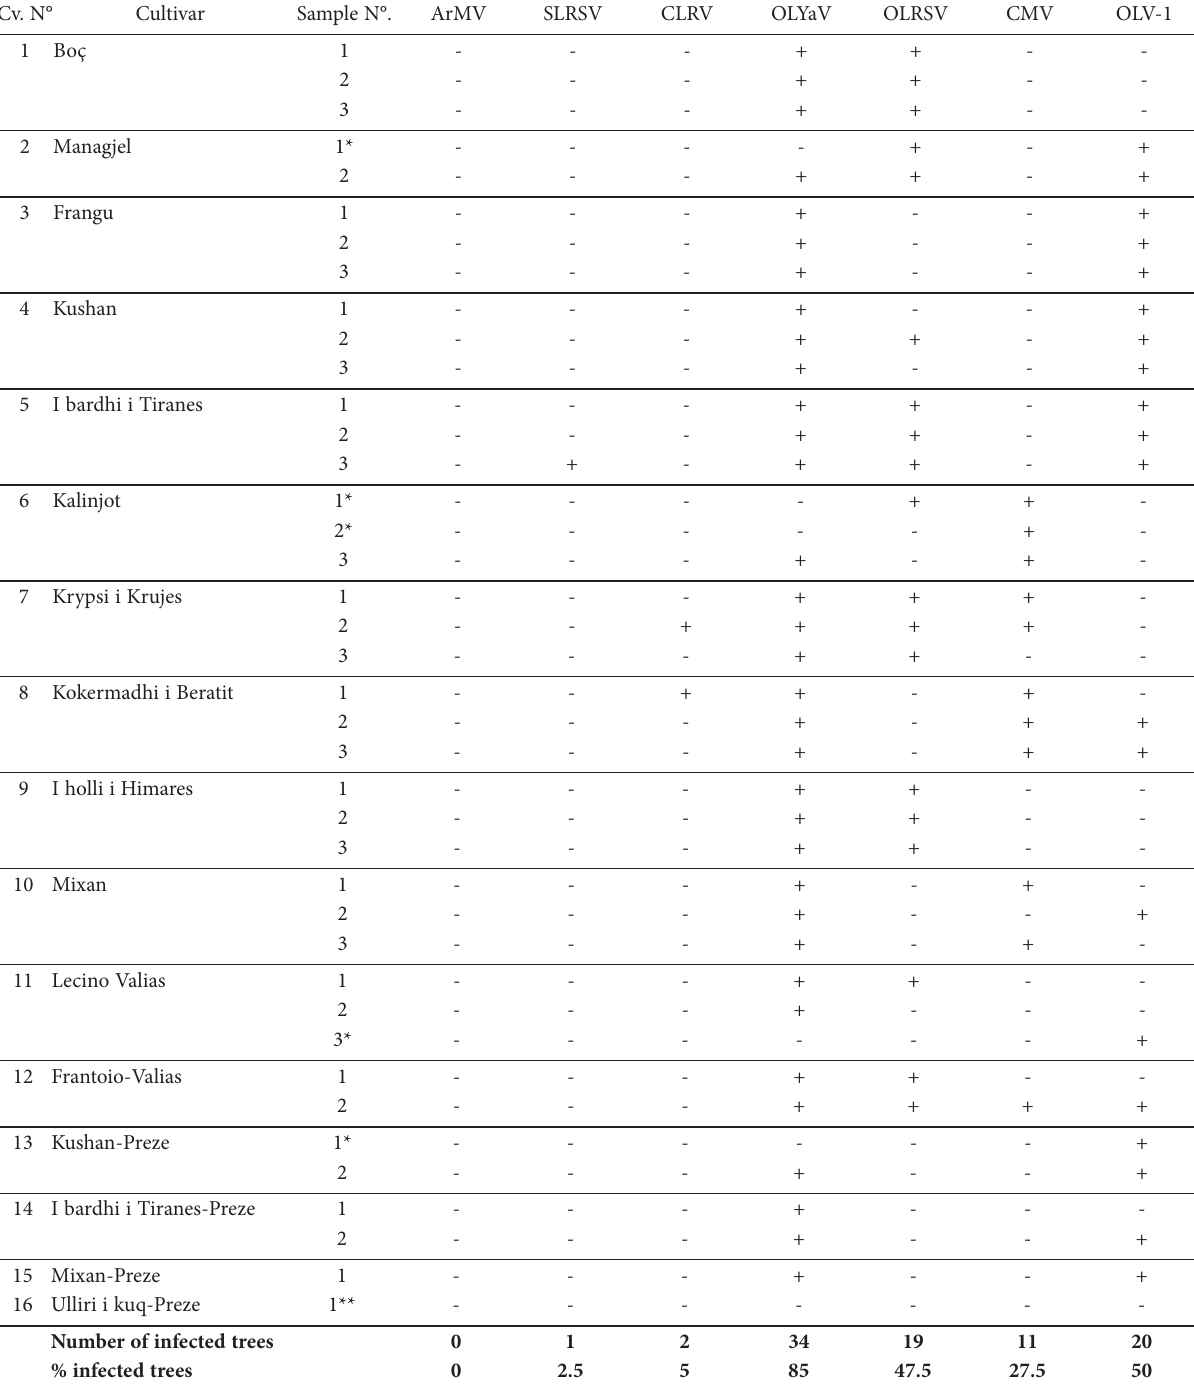
Table 1. Olive samples collected from the varietal collection plot of Valias region (Tirana, Albania), assayed by RT-PCR for the presence of seven olive-infecting viruses. * indicates CAC category plants; ** indicates Virus-tested category plant. Cv.